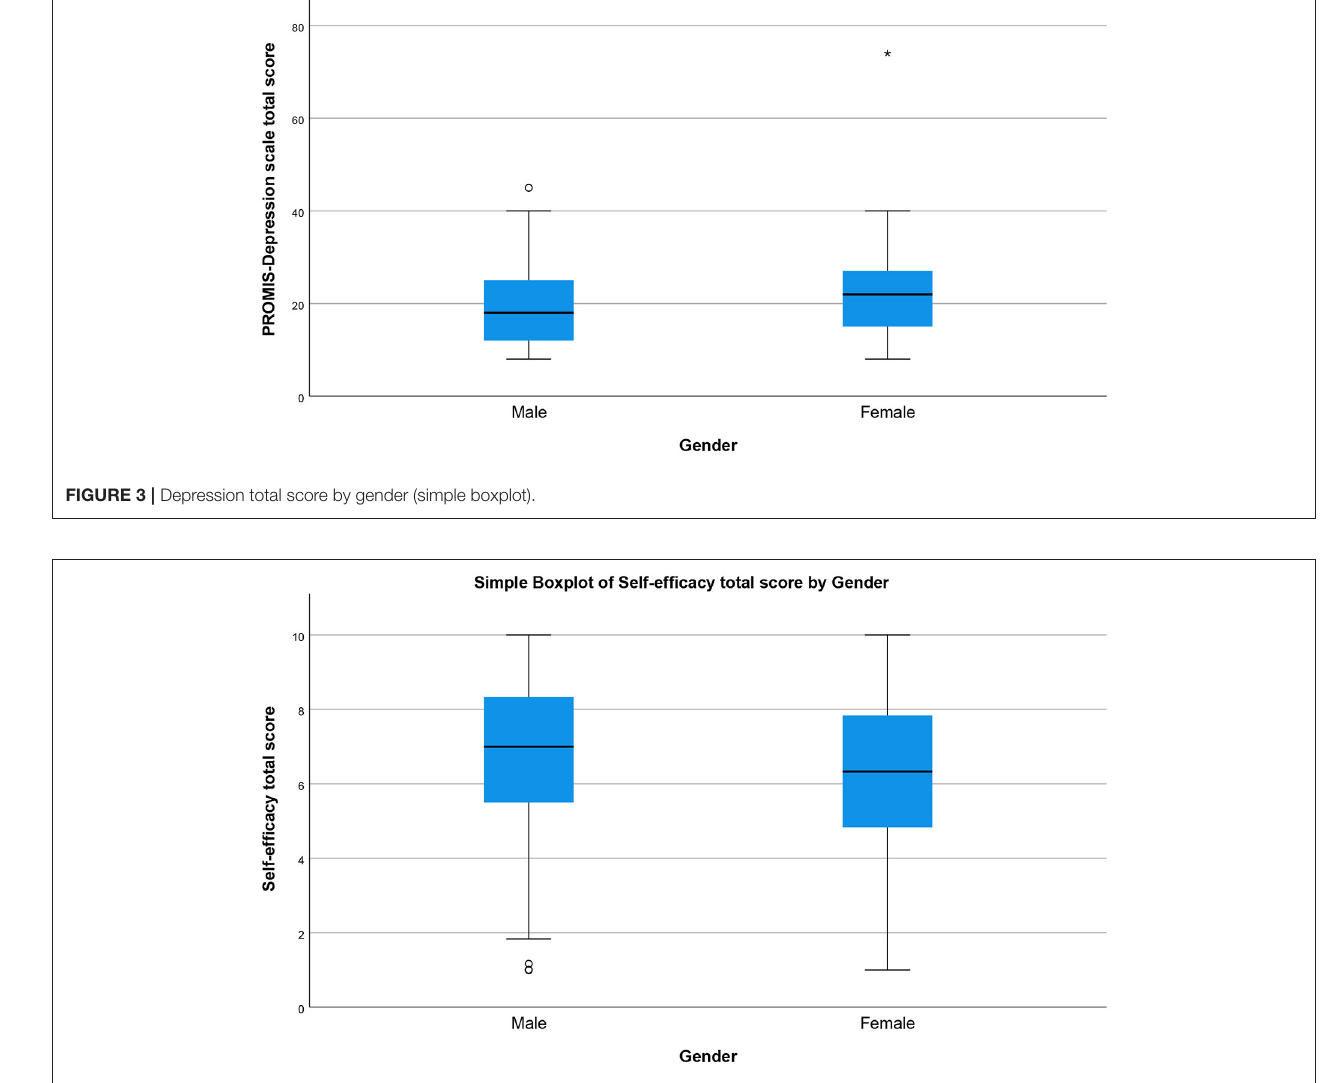
FIGURE 4 | Self-efficacy total score by gender (simple boxplot of mean).